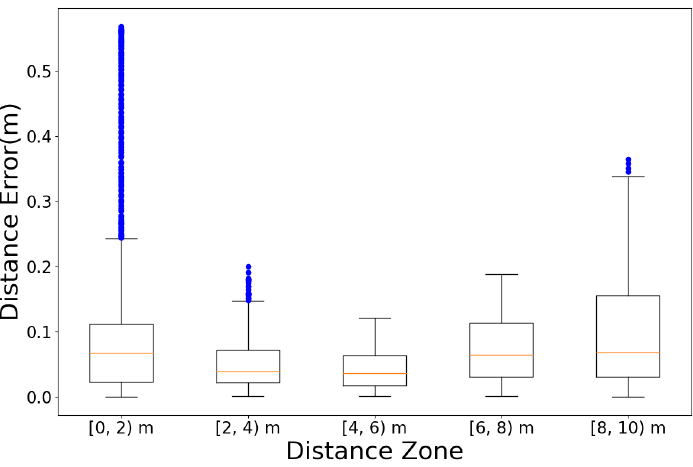
Figure 25. Distance error boxplot by distance zones: comparison with Vicon